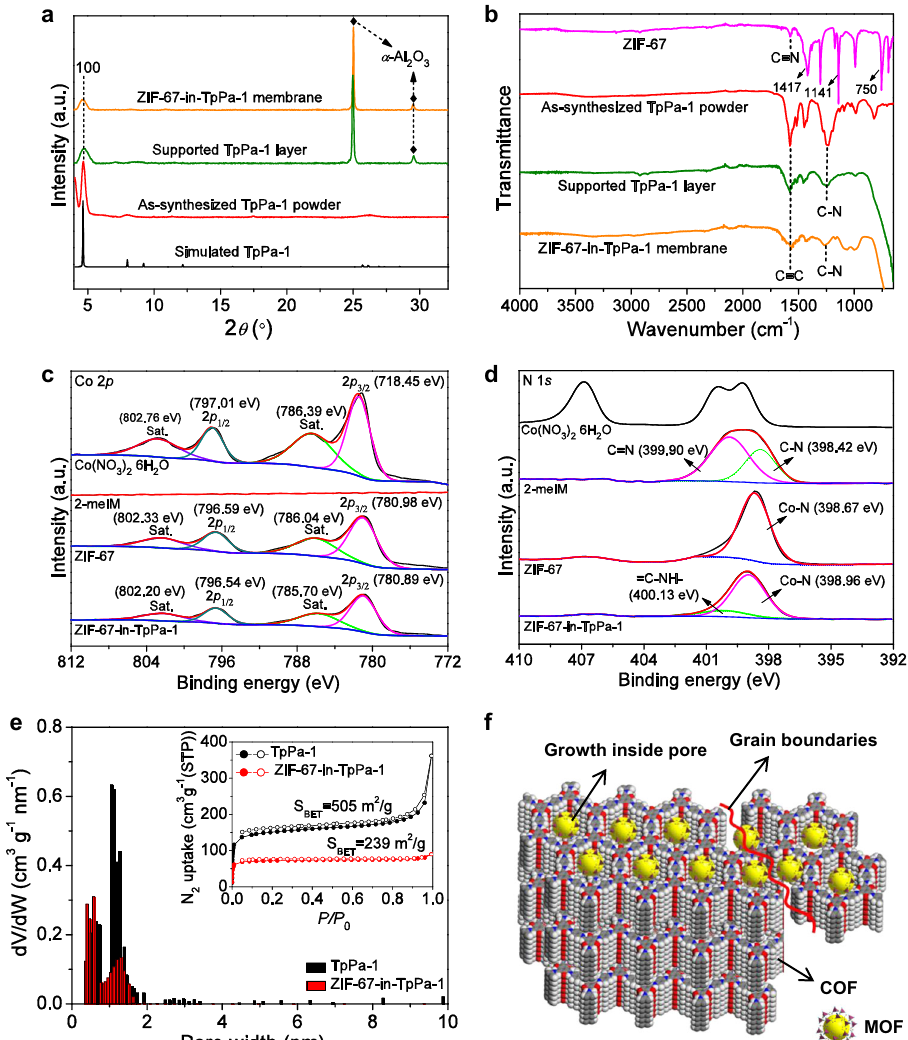
Fig. 2 Structural analysis. a XRD patterns. b FTIR spectra. c , d High-resolution XPS spectra of deconvoluted Co2 p and N1 s in different samples. e Pore-size distribution of powdered TpPa-1 and ZIF-67-in-TpPa-1 with inserted nitrogen adsorption – desorption isotherms measured at 77 K. Adsorption, closed; desorption, open. f Schematic illustrating possible growth sites of MOF inside COF